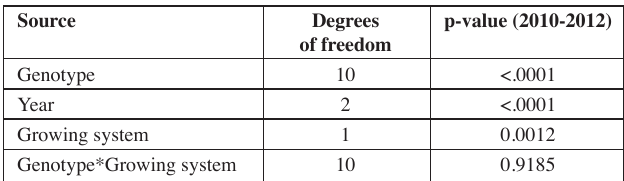
Fig. 1: Mean alkaloid content of eleven lupin genotypes cultivated under organic and conventional conditions (LS-means with the same letter are not significantly different).